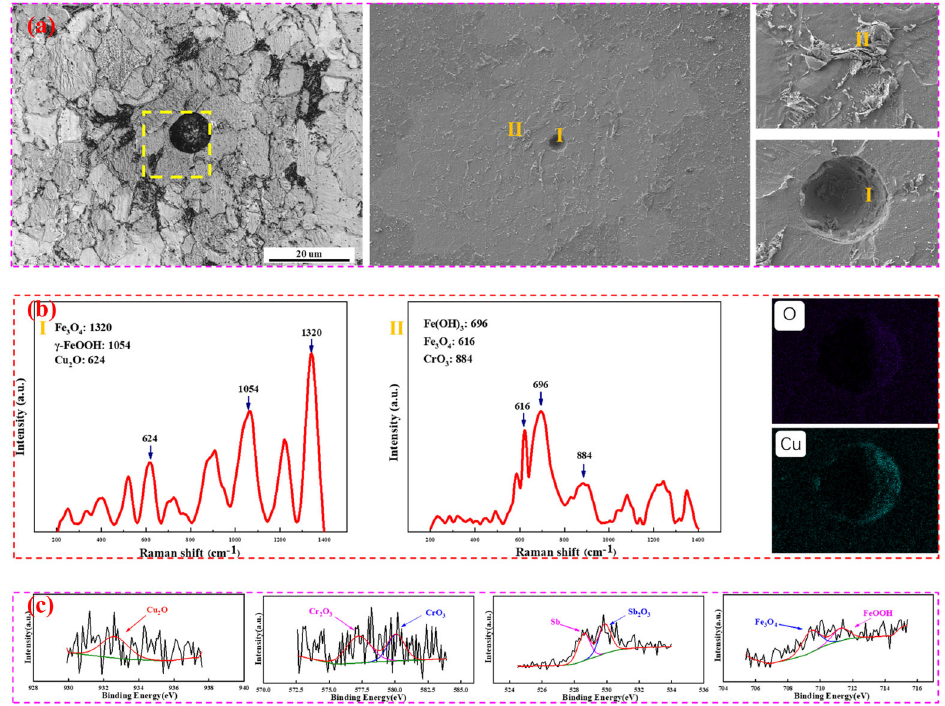
Fig. 15 Corrosion morphology and corrosion products analysis of inclusion and pearlite region. a Microscopic corrosion morphology of the CaS/CaO – MgO – Al 2 O 3 inclusion after 3600 s immersion. b EDS analysis and micro Raman analysis of the localized corrosion area after immersion. c XPS analysis of the yellow boxed